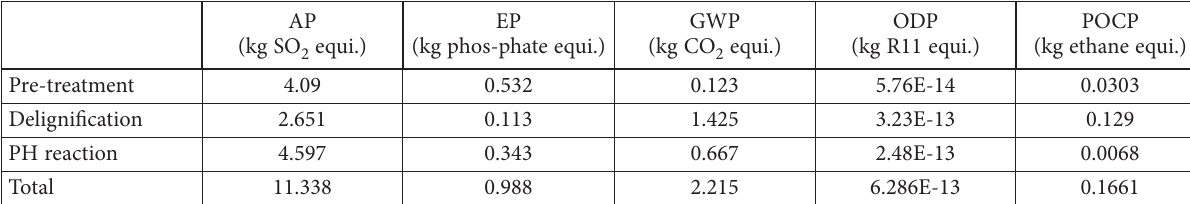
Table 3. LCA outcomes for the overall process AP (kg SO 2